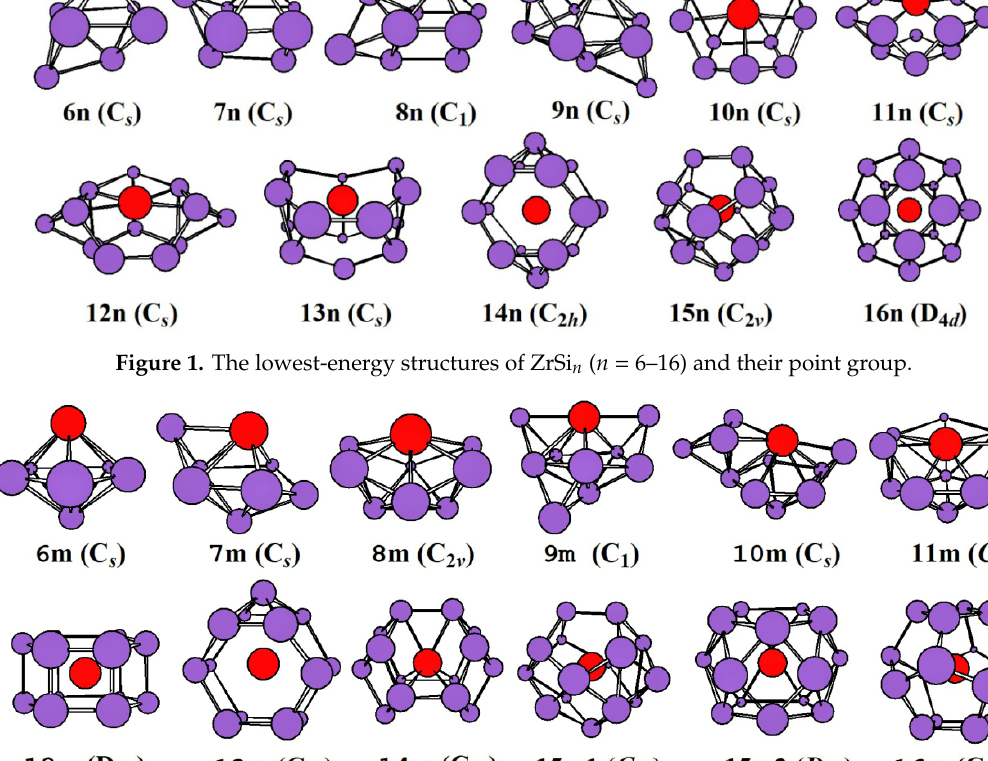
Figure 2. The lowest-energy structures of mono-anionic ZrSi n - ( n = 6–16) and their point group.